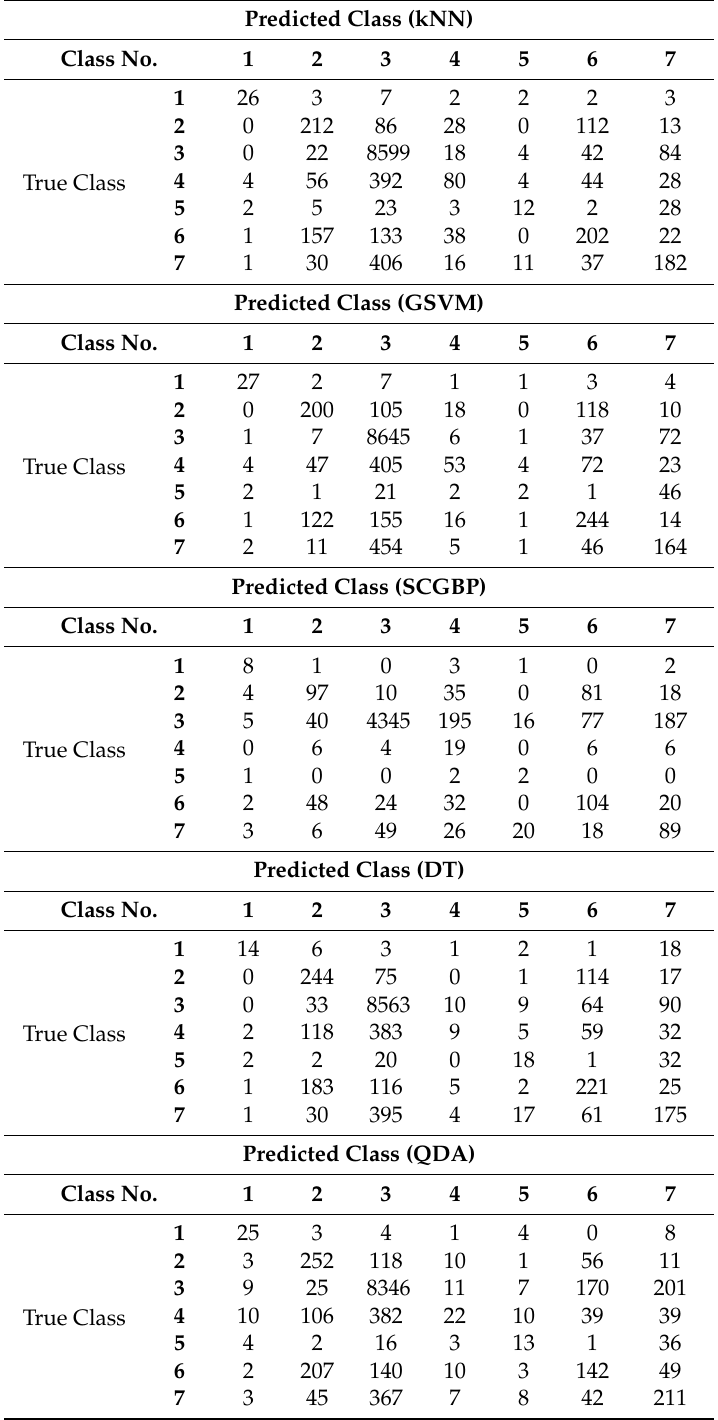
Table 7. Confusion matrices for the results obtained for the five classification